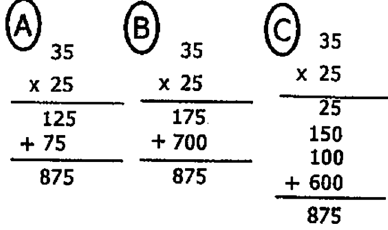
FIG. 1. Relationships between CKT, content knowledge, PCK, and KSI, based on Ball, Thames, and Phelps.